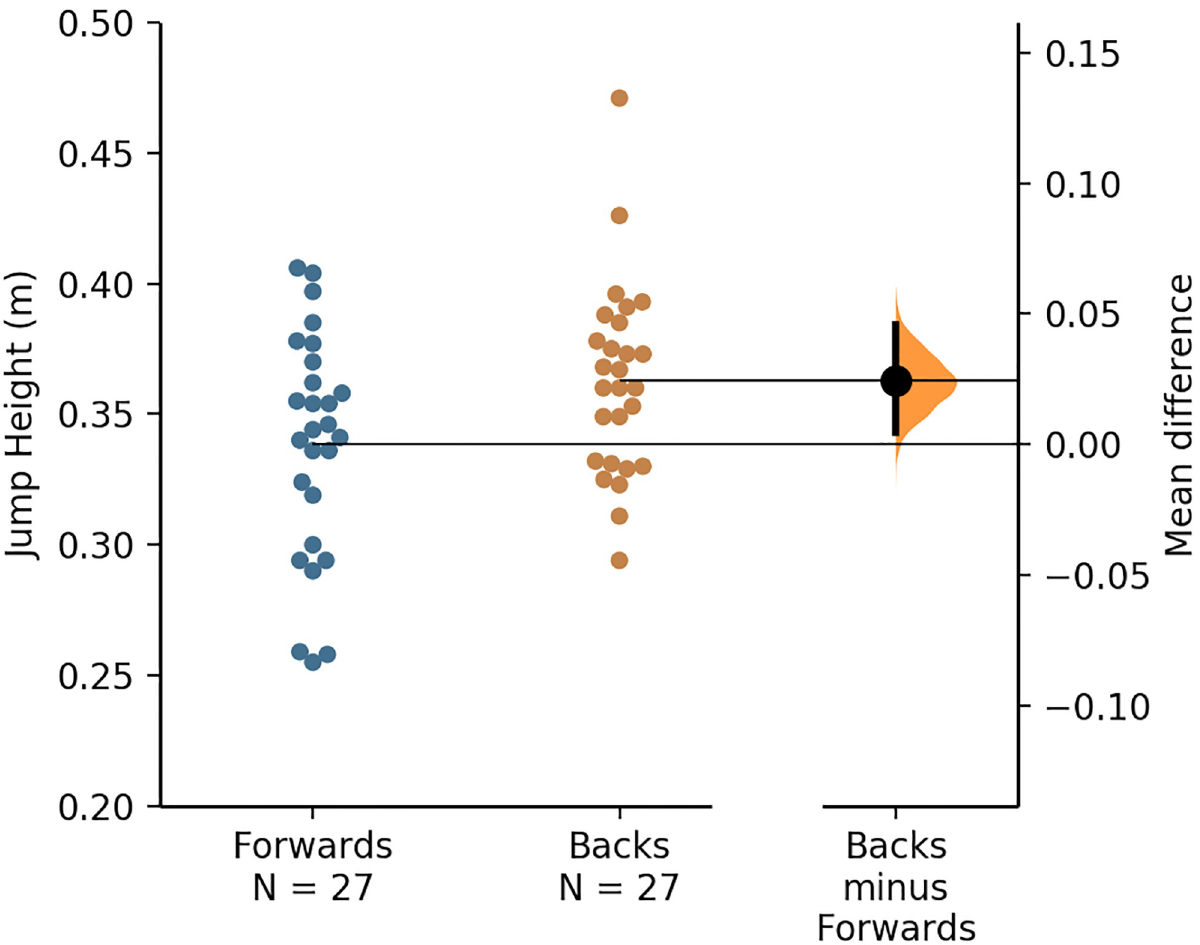
Fig 2. A Gardner–Altman plot of the forwards’ and backs’ jump height data, with the mean and mean difference for and between each positional group,